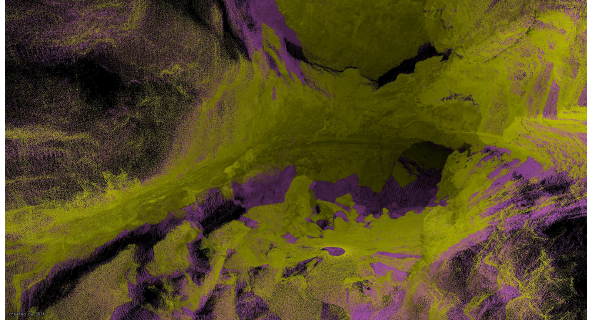
Figure 8. Comparison of dataset Trajectory3D (magenta) to ground truth (yellow). Note that the reference point cloud suffers from occlusions that are not present in the backpack